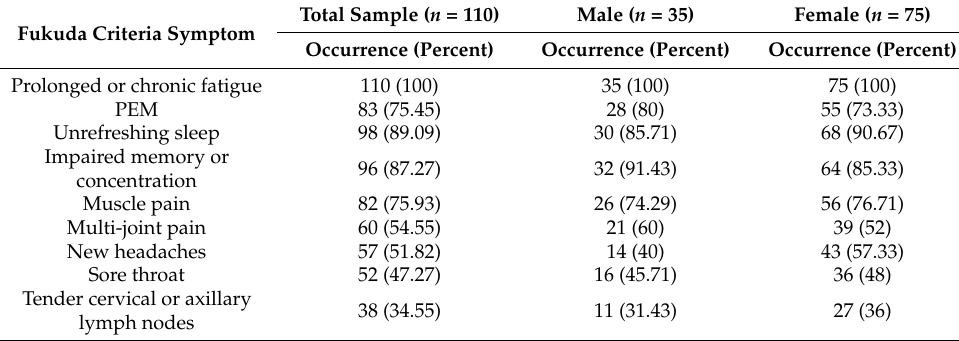
Table A2. Comparison of males and females in body